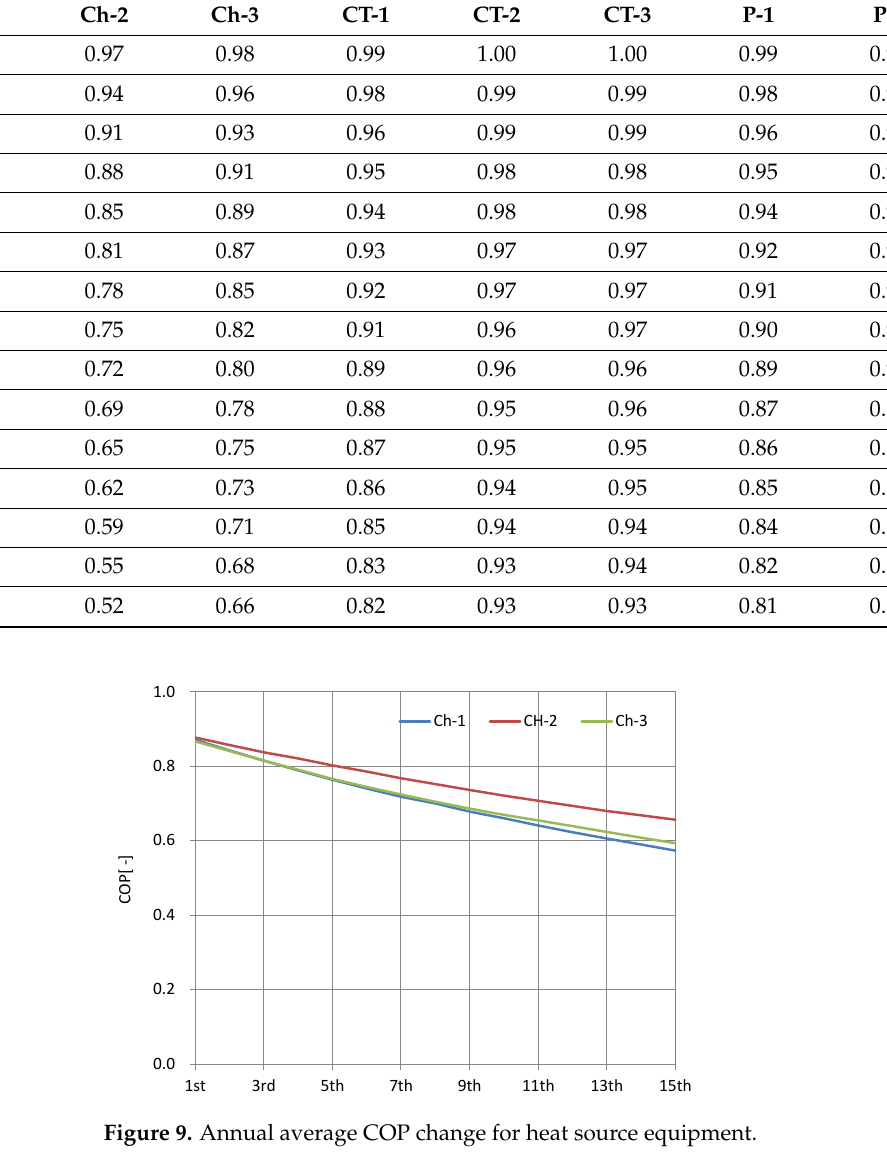
Figure 9. Annual average COP change for heat source equipment.